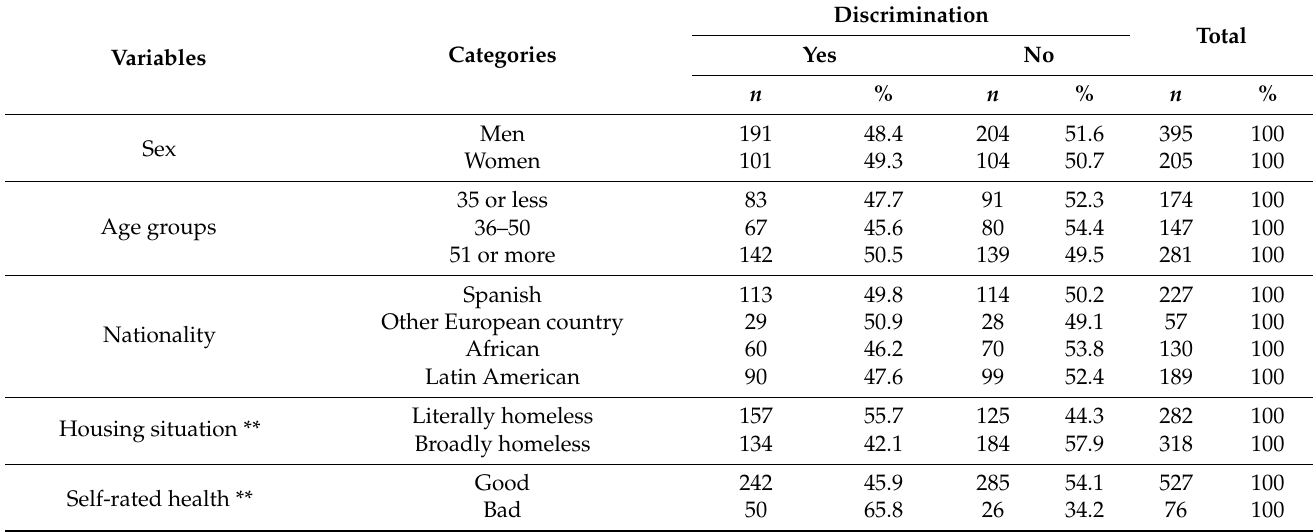
Table 4. Relations between perceived discrimination and the control variables.